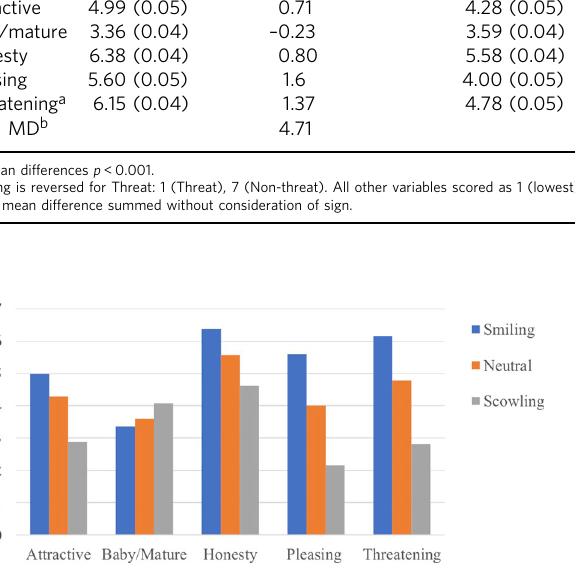
Fig. 2 Social perceptions. Means of the fi ve social perceptions (Attractive, Baby/mature, Honesty, Pleasing to look at, and Threatening) for the smiling, neutral, and scowling facial expressions, age, and gender